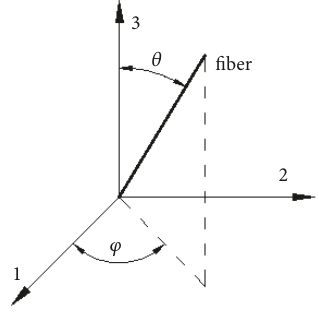
Figure 1: Schematic diagram of short fiber orientation.